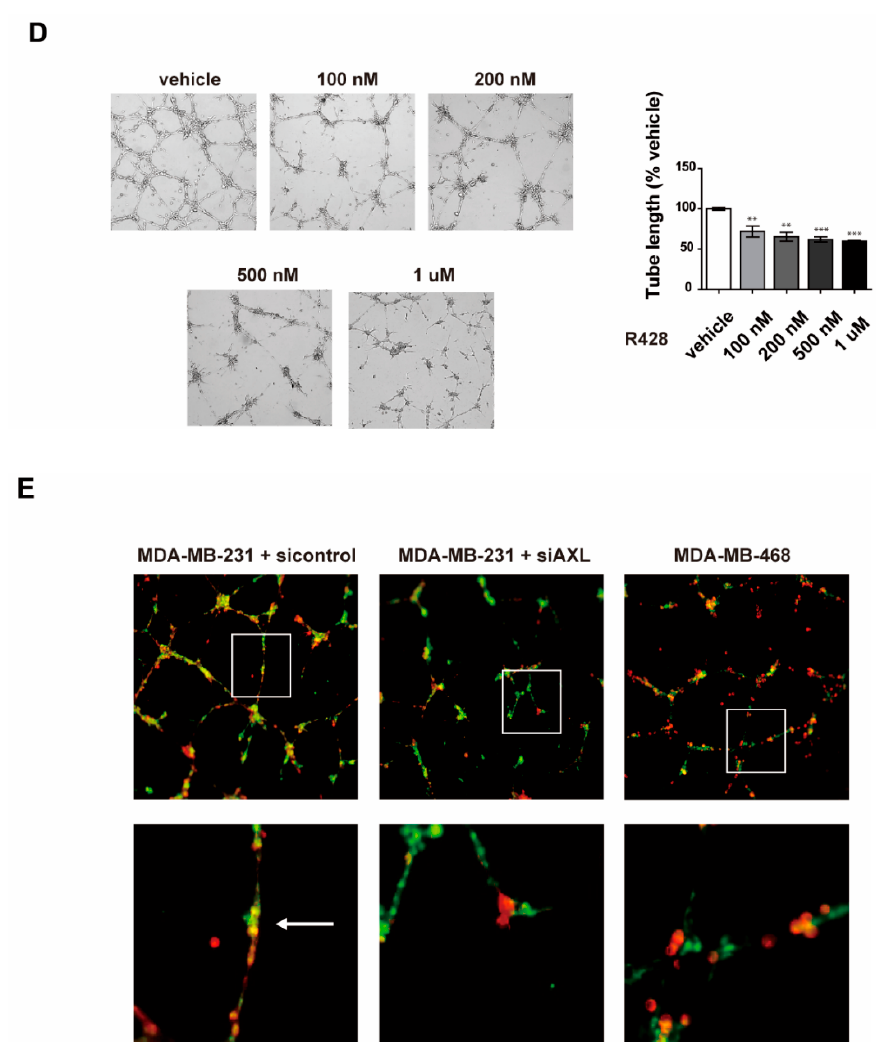
Figure 2. Inhibition of AXL suppressed vasculogenic mimicry and mosaic cords formation in MDA-MB-231 breast cancer cells. ( A ) AXL protein and ( B ) mRNA expression in AXL-knockdown MDA-MB-231 breast cancer cells. ( C ) Inhibition of VM formation in response to AXL knockdown by siRNA in MDA-MB-231, BT-549, and HS578T breast cancer cells. ( D ) Inhibition of VM formation via R428 treatment at 100 nM, 200 nM, 500 nM, and 1 µ M in MDA-MB-231 breast cancer cells. ( E ) Co-culture three-dimensional culture assays with breast cancer cells (red) and HUVECs (green). Mosaic cord structure (arrow). * p < 0.05, ** p < 0.01, *** p < 0.001 versus controls, calculated using unpaired two-tailed Student’s t -test. Error bars, S.E.M.